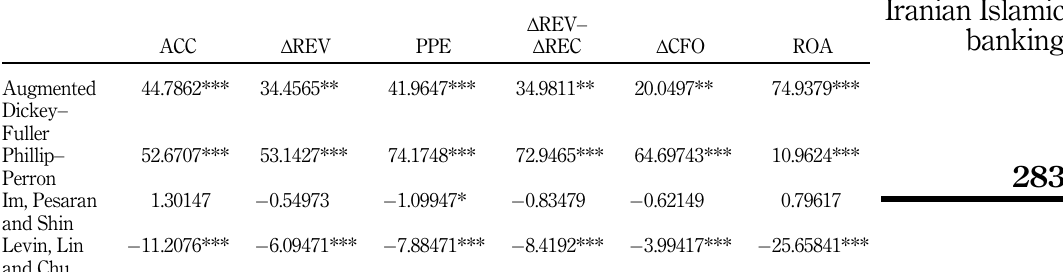
Table 3. Unit root tests